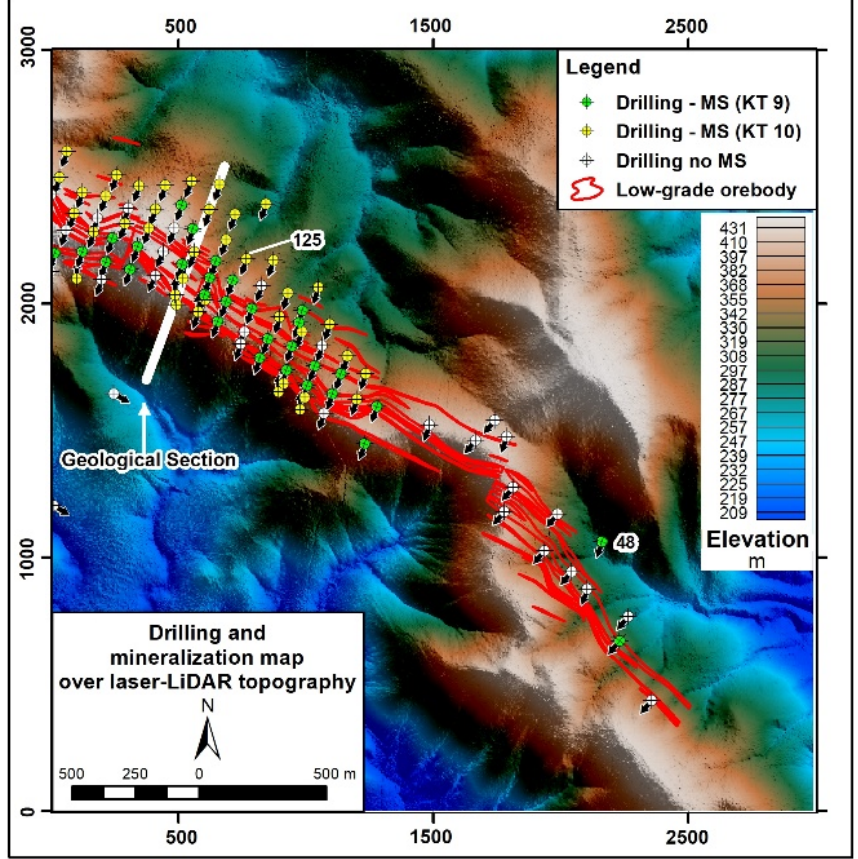
Figure 6. Drill hole location map. Measurement schematics: Lower sensitivity magnetic susceptibility (MS) measurements (KT-9) in green; higher sensitivity MS measurements (KT-10) in yellow; drill holes without MS measurements in white; and low-grade orebody projections at an elevation of 190 m in red. The geological section location (see Figure 4) is indicated in the map, and the numbers of drill holes, 48 and 125 used in this study, are indicated.